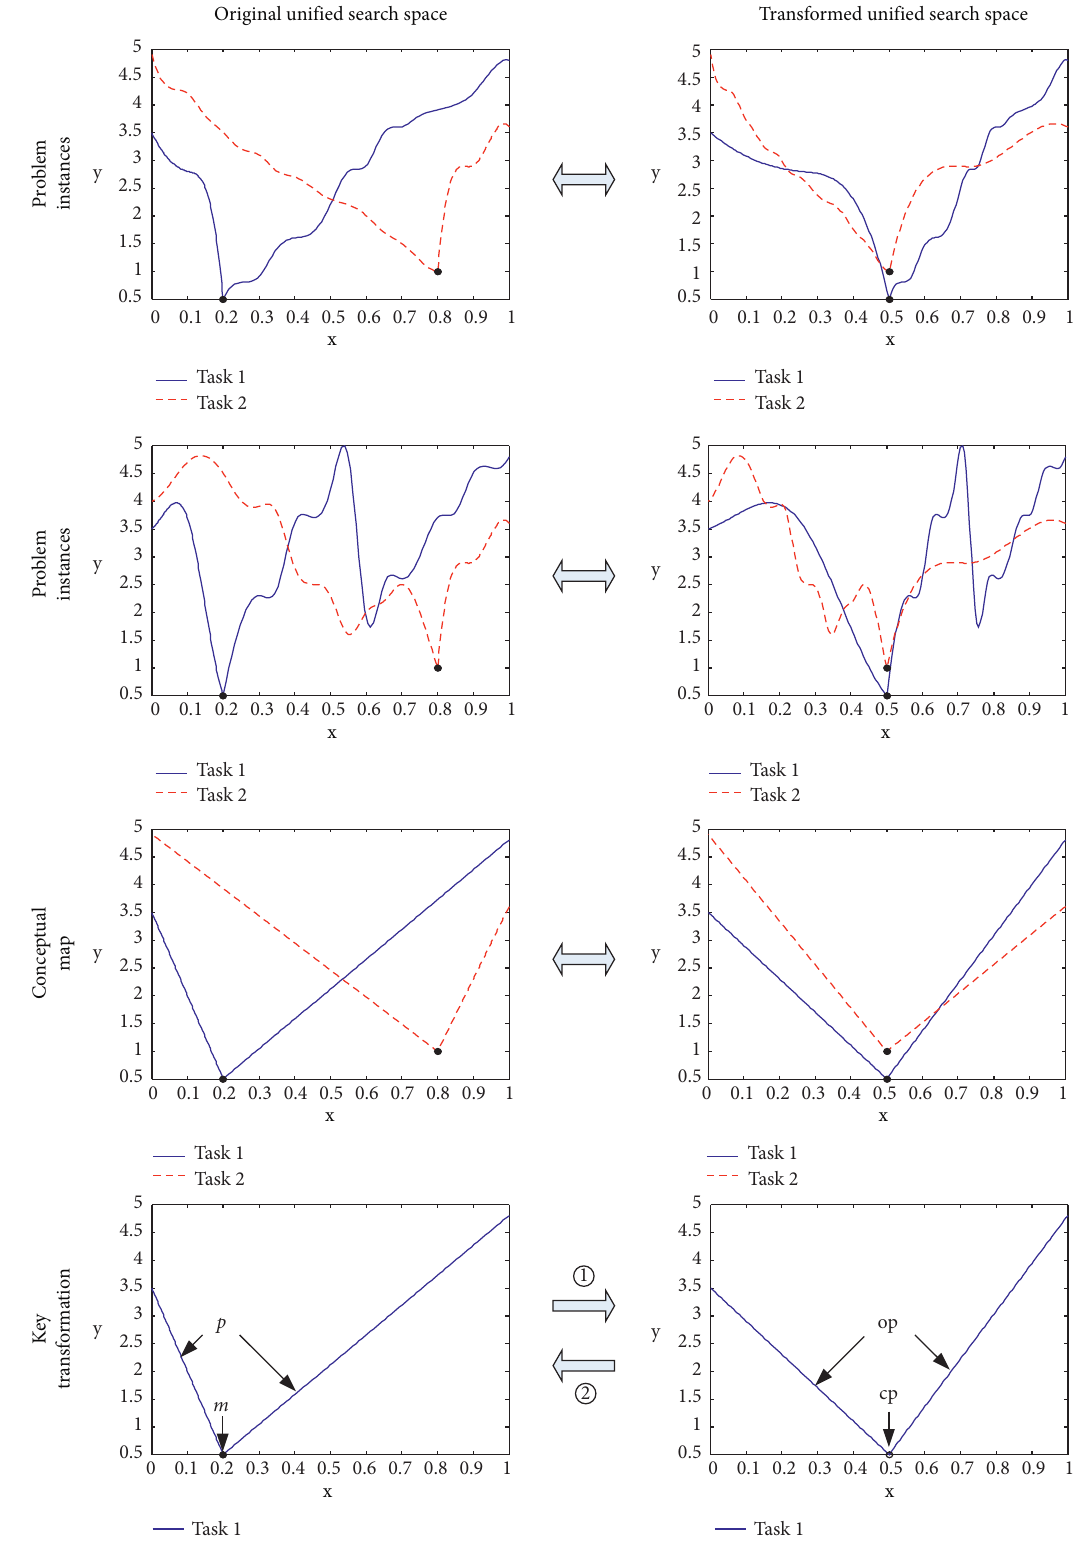
Figure 1: Problem instances and conceptual map of multitasking optimization